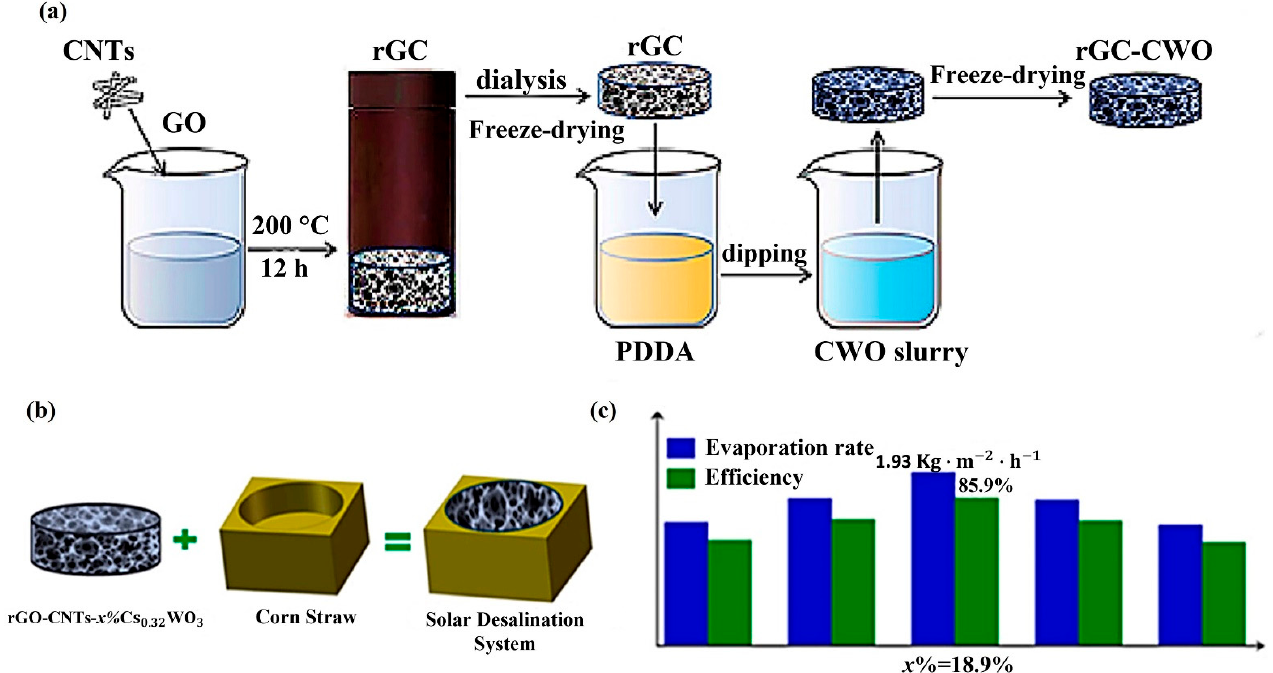
Figure 4. ( a ) Illustration of the preparation process of rGC-CWO aerogel. ( b ) Schematic diagram of rGC-CWO/CS evaporator. ( c ) The corresponding systems’ evaporation rates and efficiency (reproduced with permission, Copyright 2022 Elsevier [54]).